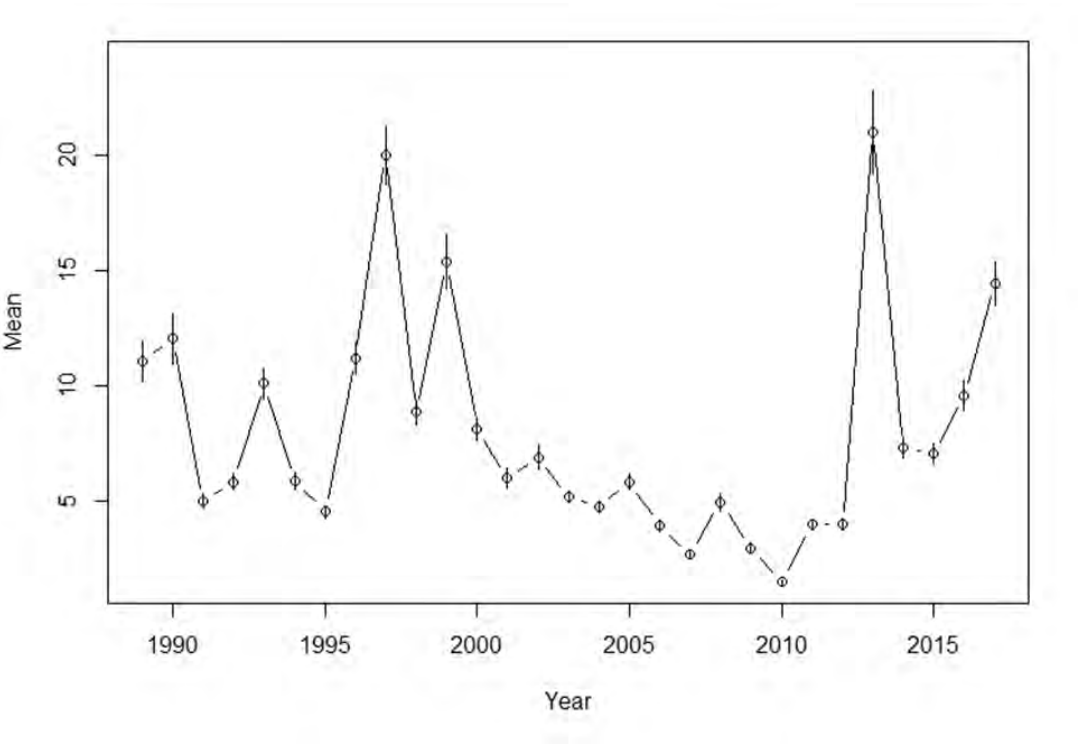
Figure 43. Abundance index for all horseshoe crabs in the spring (April and August) samples from New Jersey’s Ocean Trawl Survey.